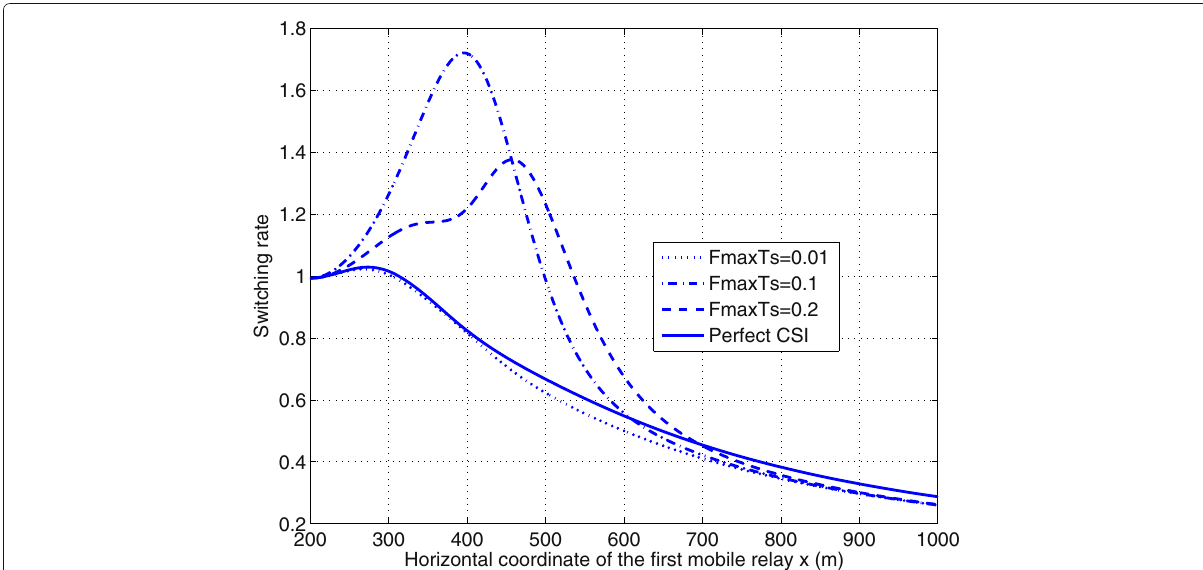
Fig. 9 The switching rate, normalized to the maximum Doppler frequency vs. the horizontal coordinate of the first MR antenna x for different maximum normalized Doppler spread with reference SNR γ = 20 dB